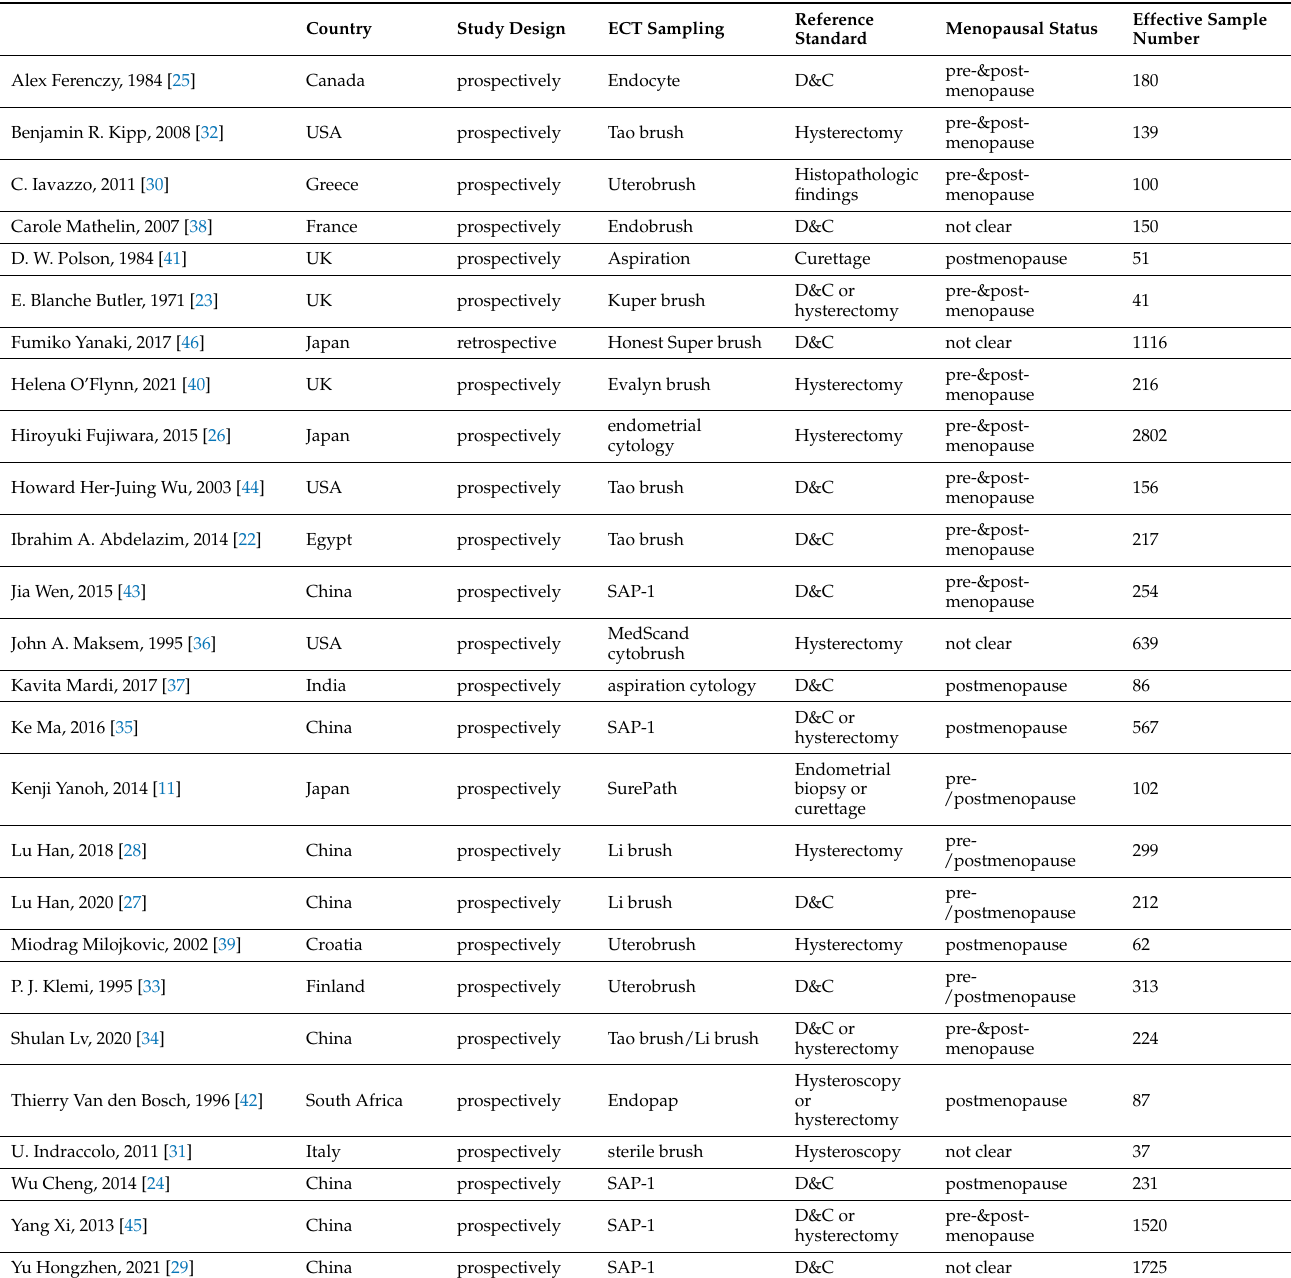
Table 1. Study characteristics of the 26 included